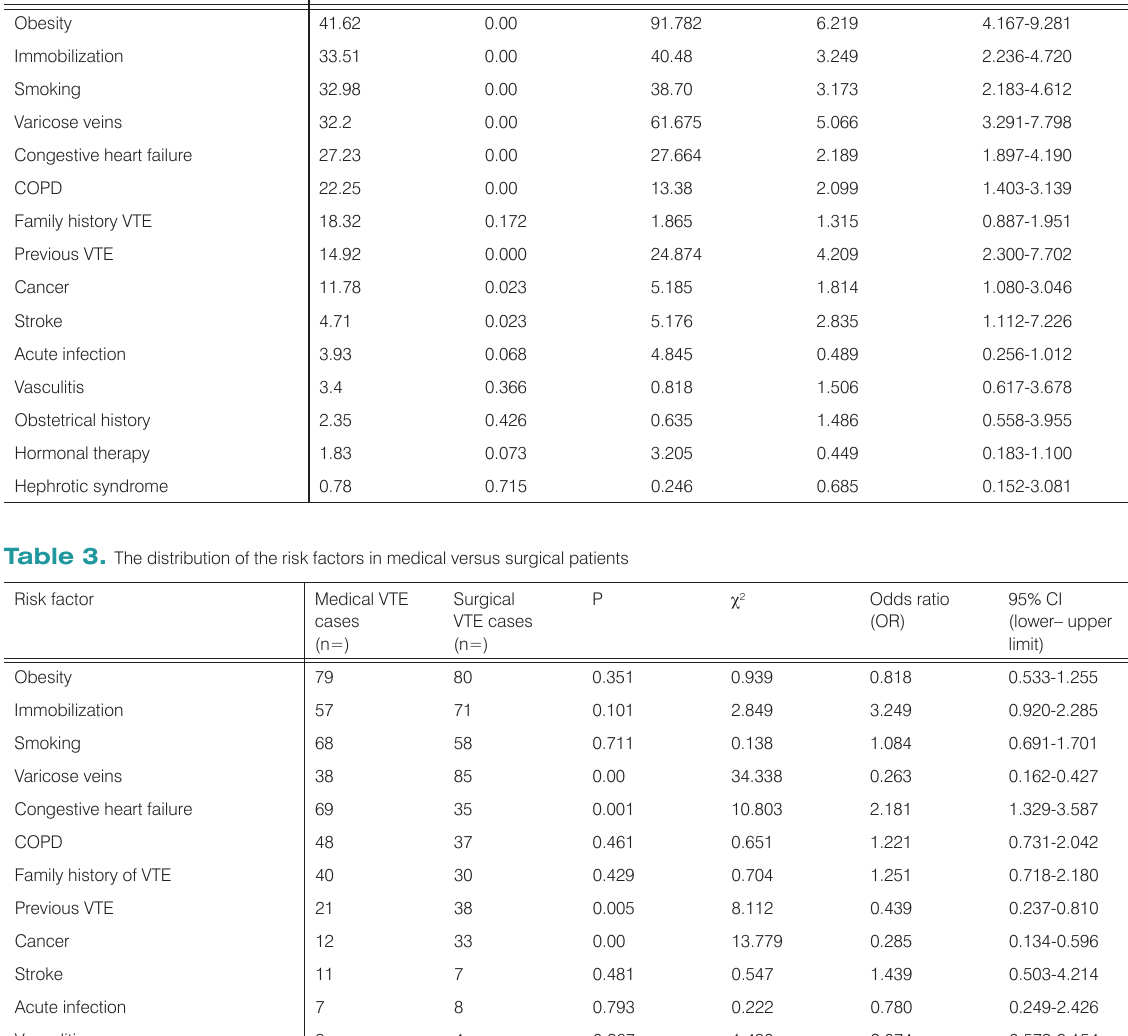
Table 2. The frequency and associated risk of factors in VTE Risk factor